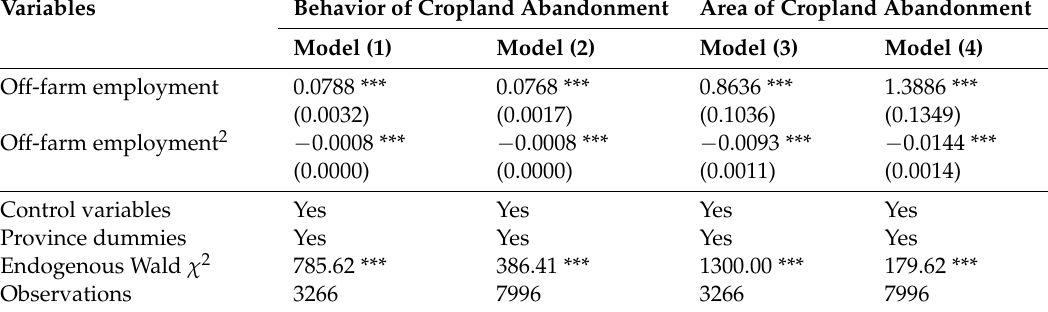
Table 4. The estimated results of robustness checks a